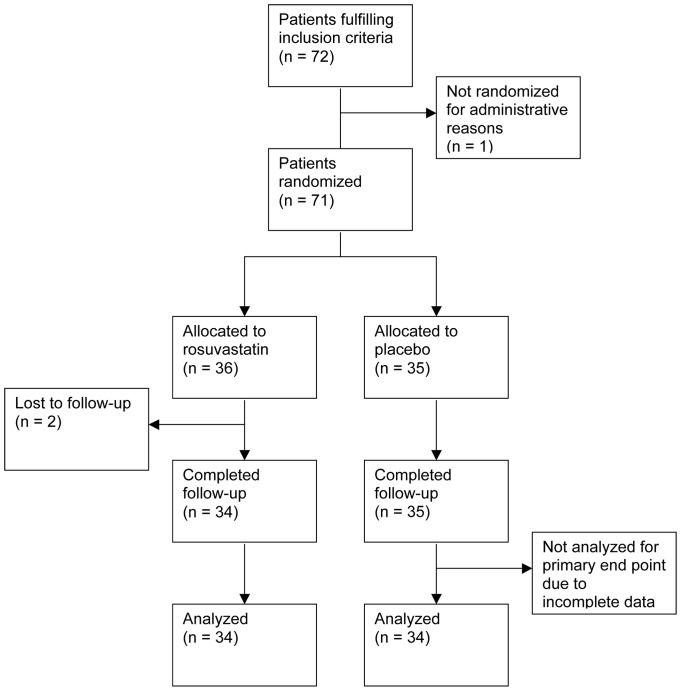
Trial flow chart.